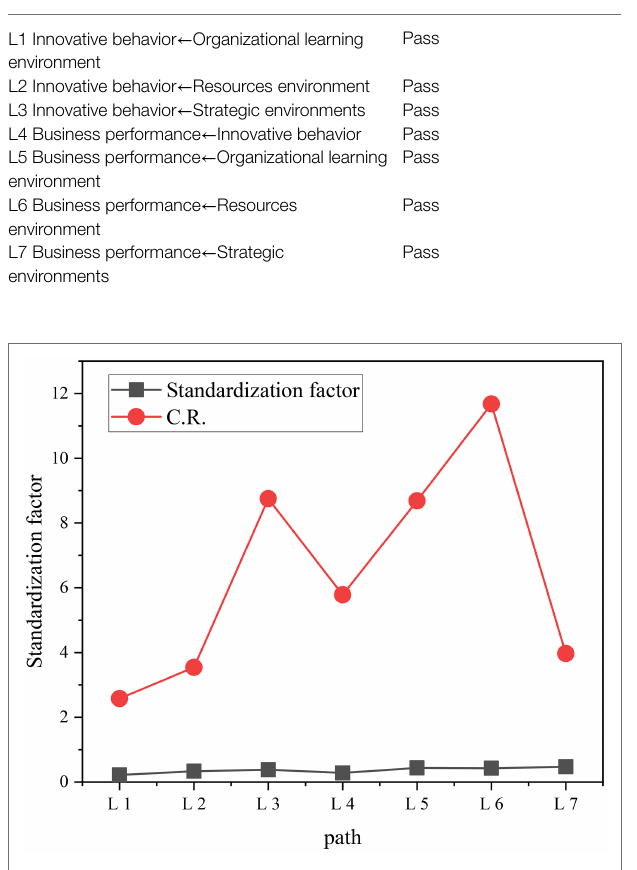
TABLE 3 | Statistical table of structural equation model results. Path Conclusion ( p < 0.05)